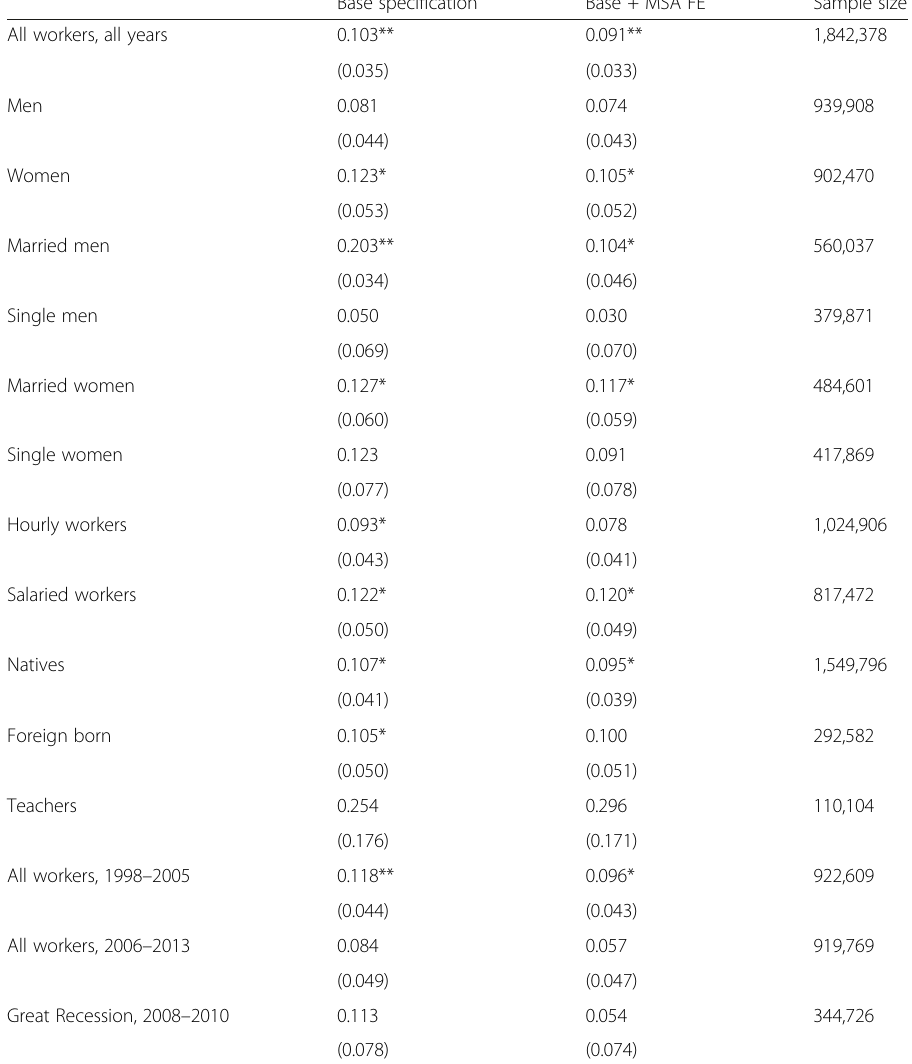
Table 4 Employment growth effects on multiple job holding, by worker group Base specification Base + MSA FE Sample